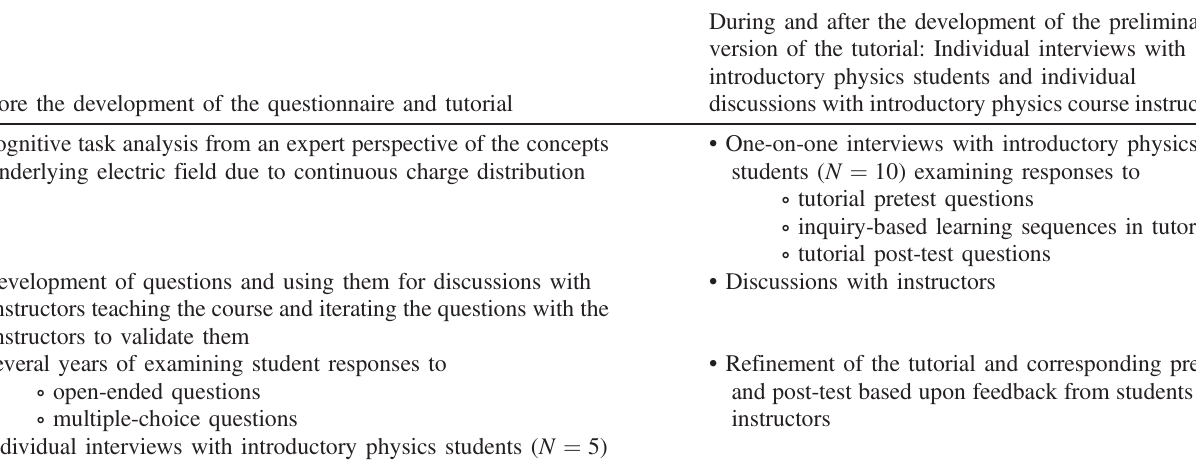
TABLE I. Procedure for data collection before, during, and after the development and validation of the questionnaire and different versions of the